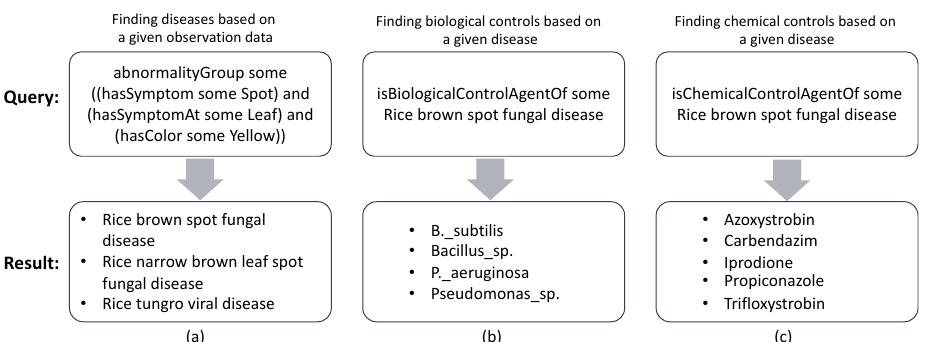
Figure 5. DL queries and results of finding possible diseases and controls for a disease: ( a ) a DL query of finding the corresponding rice diseases given an observation, ( b ) a DL query of finding biological controls for the rice brown spot fungal disease, and ( c ) a DL query of finding chemical controls for the rice brown spot fungal